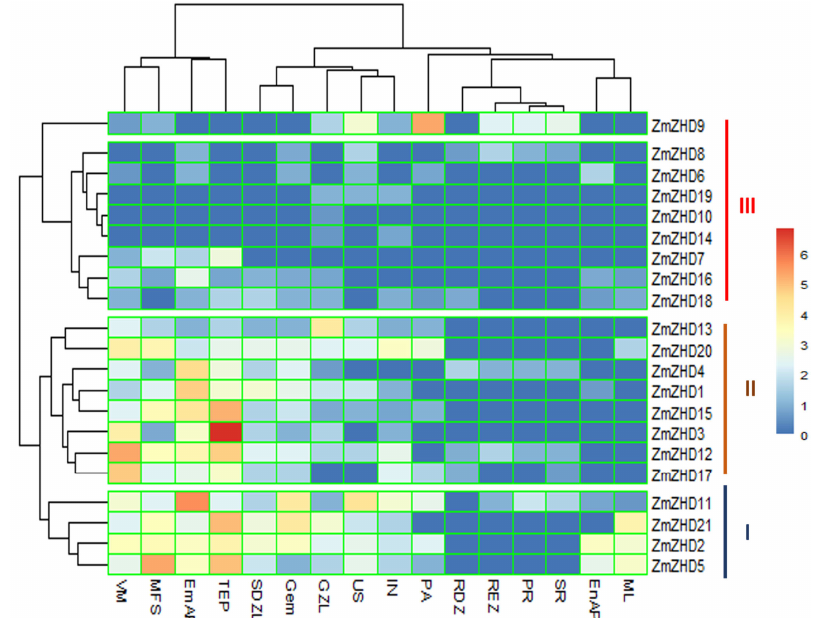
Figure 8. Heatmap showing the expression levels of ZmZHD genes in different tissues. Normalized Log2 (FPKM + 1) values are plotted against respective tissues. Tissue name abbreviations are as follows: unpollinated silk (US), vegetative meristem (VM), pericarp and aleurone (PA), embryo after pollination (EmAP), endosperm after pollination (EnAP), internode (IN), mature leaf (ML), mature female spikelet (MFS), primary root (PR), secondary root (SR), root differentiation zone (RDZ), root elongation zone (REZ), stomatal divisional zone of the leaf (SDZL), tip of the primordium (TEP), germinated embryo (Gem), growth zone of the leaf (GZL).